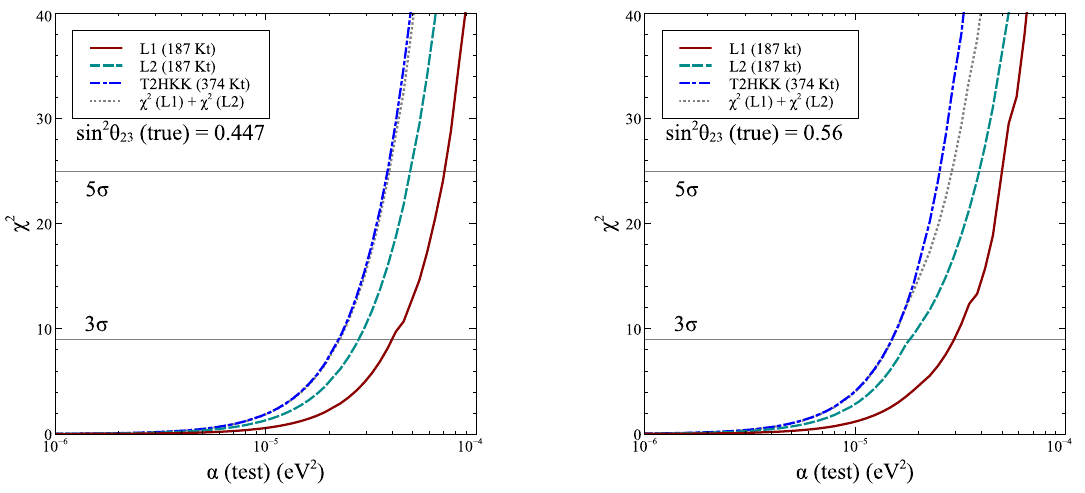
Figure 4 . The χ 2 as a function of α , assuming no decay in the simulated data. The left (right) panel is for θ 23 (true) in the lower (higher) octant. The dark red solid, cyan dashed, blue dashed-dotted curves are for a 187 kt detector at 295 Km, 187 kt detector at 1100 km and their combination respec- tively. The grey dotted curve shows the χ 2 if we just add the χ 2 s of the dark red and cyan